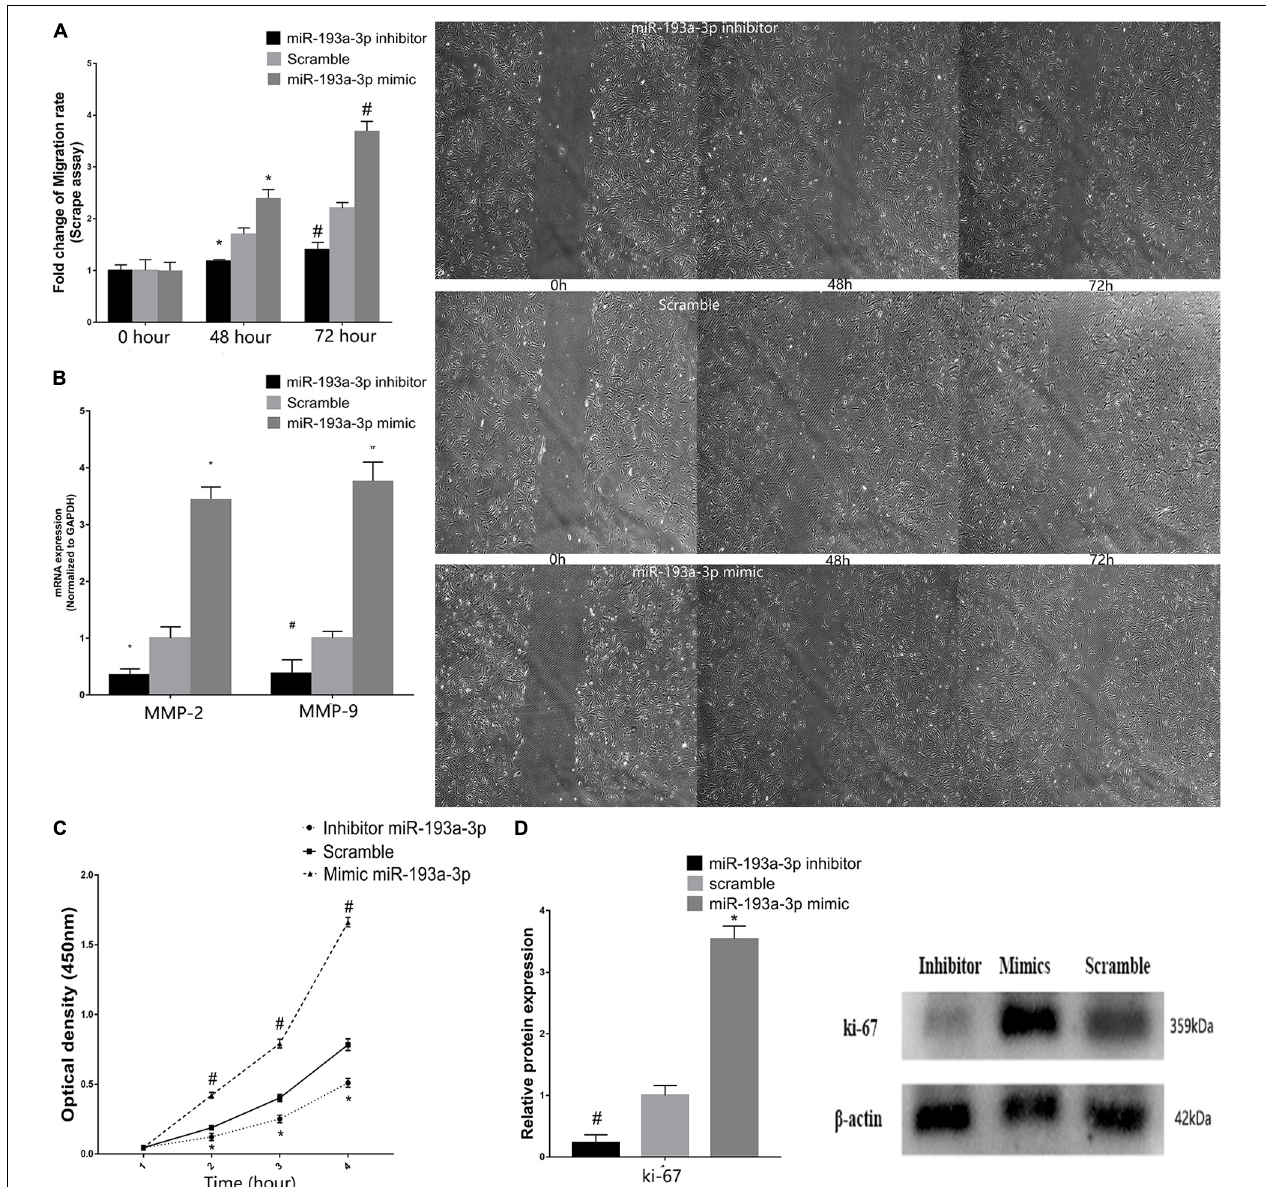
FIGURE 7 | miR-193a-3p in VSMC proliferation and migration. (A) Scrape assay showing the reduction in the migration of human aortic VSMCs transfected with miR-193a-3p inhibitor. Cells transfected with the miR-193a-3p mimic exhibited enhanced cell migration (* P ≤ 0.05 vs. Scramble, # P ≤ 0.05 vs. Scramble). (B) qRT-PCR showing the increase in mRNA levels of MMP-2 and MMP-9 in VSMCs transfected with the miR-193a-3p mimic. (C) The miR-193a-3p mimic enhanced VSMC proliferation as measured by the cell counting kit-8 ( n = 10, * P < 0.05 vs. 1 h, # P ≤ 0.05 vs. Scramble). (D) Western blots showing the upregulation of Ki-67 in cells transfected with the miR-193a-3p mimic (* P ≤ 0.05 vs. Scramble, # P ≤ 0.05 vs.